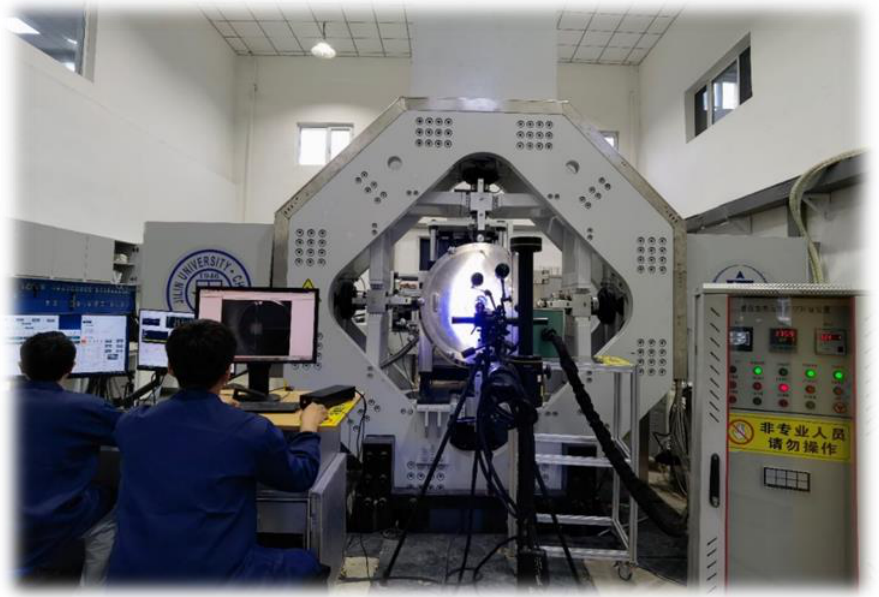
Figure 13. Experimental setup of the